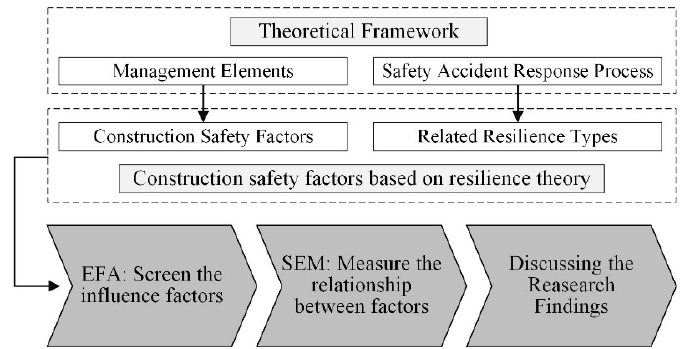
Figure 3. The research phases developed for this paper.